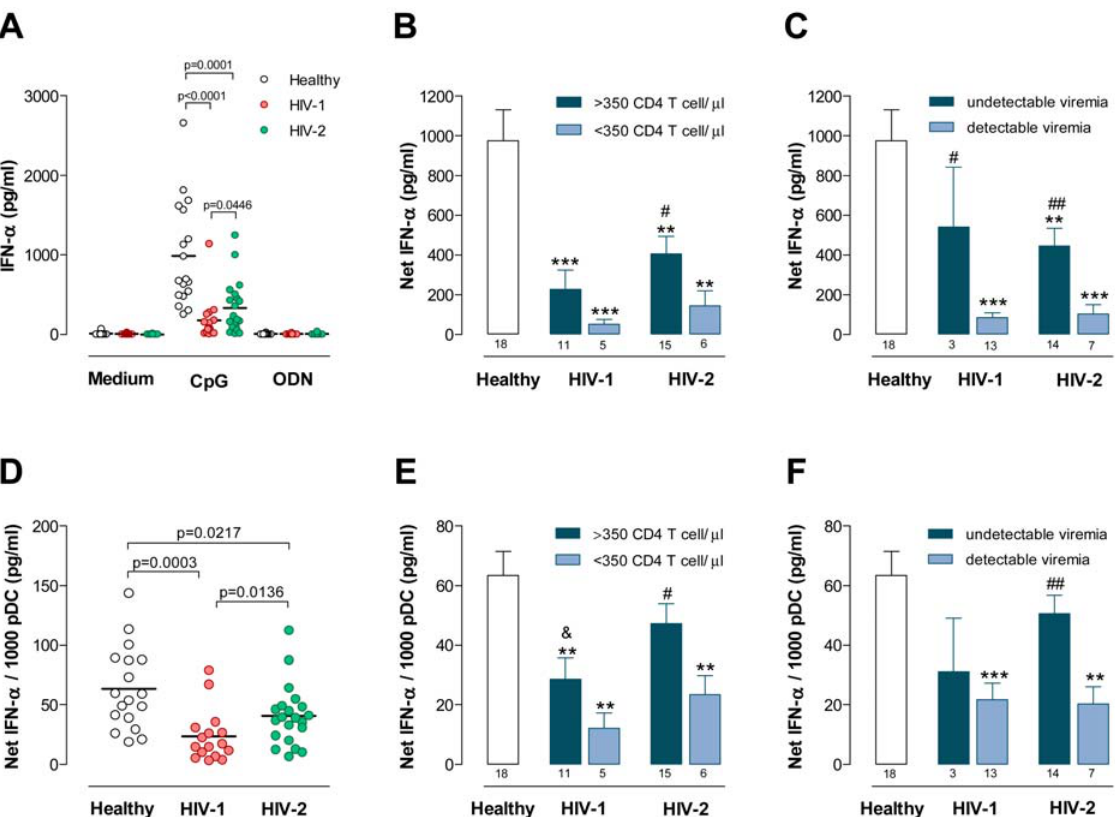
Figure 4. IFN- a production upon CpG stimulation. Freshly isolated PBMC were stimulated with CpG or the non-CpG ODN control. After 22 hours IFN- a was quantified in culture supernatants by ELISA. ( A ) Levels of IFN- a upon CpG or the non-CpG ODN control in healthy, HIV-1 and HIV- 2 cohorts. The infected cohorts were further stratified according to CD4 T cell counts ( B ) or the presence or absence of detectable viremia ( C ) and the levels of IFN- a upon CpG stimulation are shown. Results expressed as ‘‘Net IFN- a ’’ refer to the amount of IFN- a produced upon CpG stimulation subtracted by the IFN- a measured with medium alone. The ‘‘Net IFN- a ’’ was divided by the total number of pDC in the culture and results are shown for the healthy, HIV-1 and HIV-2 cohorts ( D ), as well as for the infected cohorts stratified according to CD4 T cell counts ( E ) or the presence or absence of detectable viremia ( F ). Each dot represents one individual. Bars represent mean 6 SEM. Numbers under the bars represent the total individuals analyzed. The subgroups of patients analyzed are representative of their respective patient population described in Table 1 with respect to CD4 counts and viral load. ** p , 0.01 and *** p , 0.001 as compared to controls. # p , 0.05 and ## p , 0.01 between the two groups of the same infected cohort. & p , 0.05 between HIV-1 and HIV-2 patients with more than 350 CD4 T cells/ m